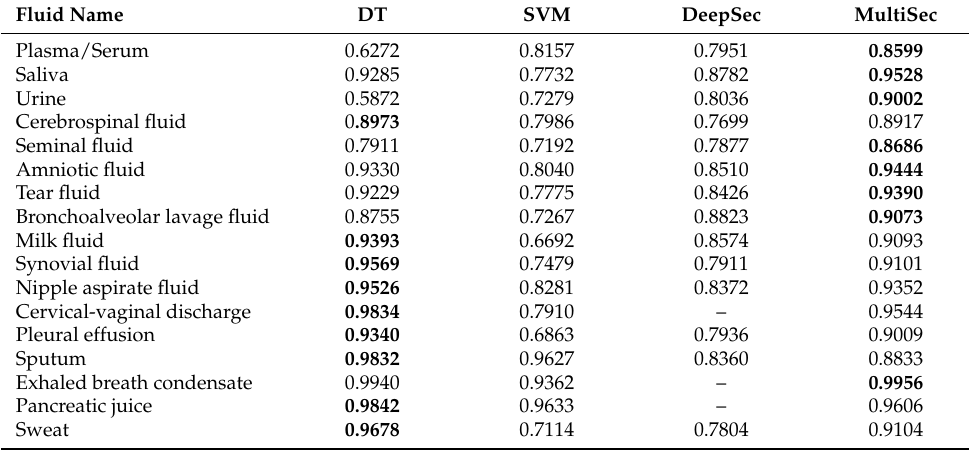
Table A3. SP benchmarks of MultiSec and compared methods on the independent testing datasets of 17 human body fluids.